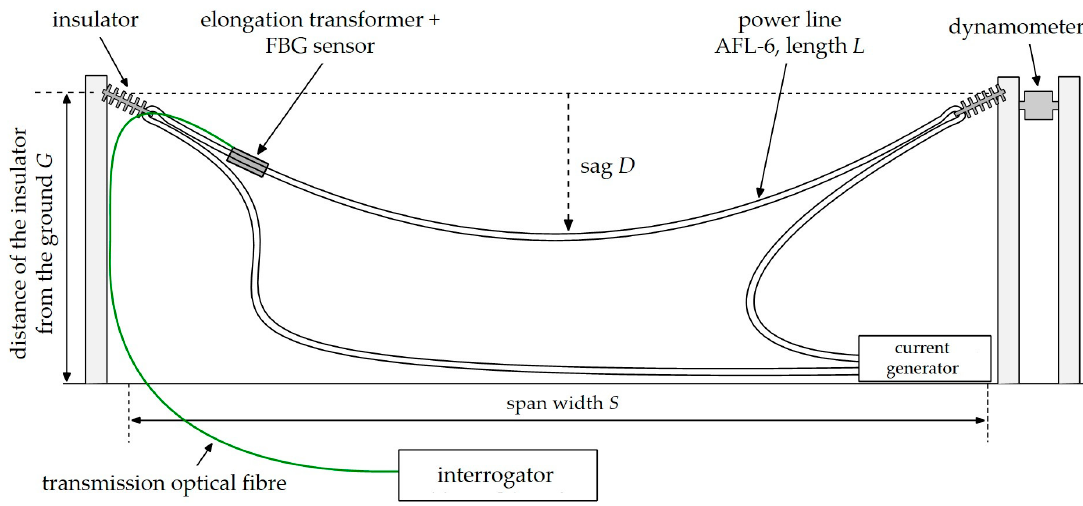
Figure 20. The overhead power line span at the outdoor testbed with the method of its characteristics’ parameters measurement.